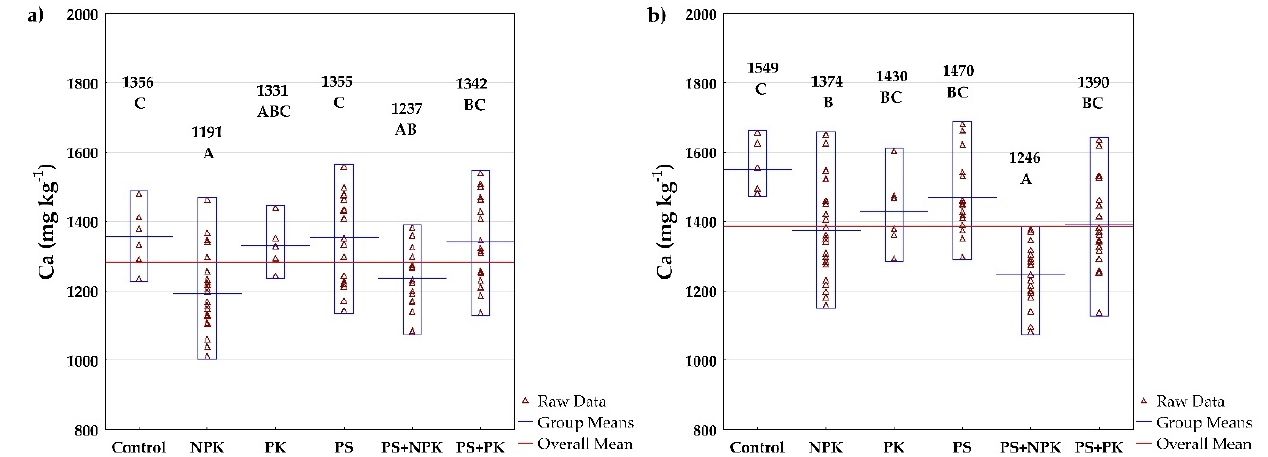
Figure 4. The effect of fertilizer treatments on soil Ca concentration in ( a ) Pernolec and ( b ) Kostelec (2015 – 2020). Mean values followed by the same letter are not significantly different. Red triangles represent the raw data. The blue lines represent the mean value of the particular treatment, while the red line represents the mean value calculated from all fertilizer treatments.